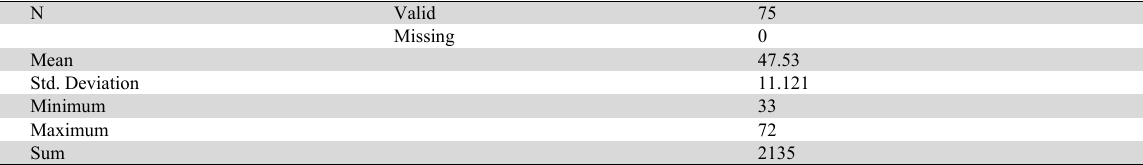
Statistical Variables of Service Stakeholder Commitment (X 2 ) N Valid